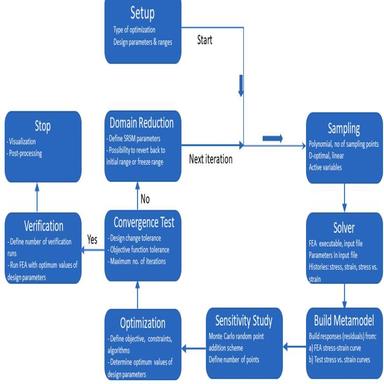
Flow chart for the Optimization Method.